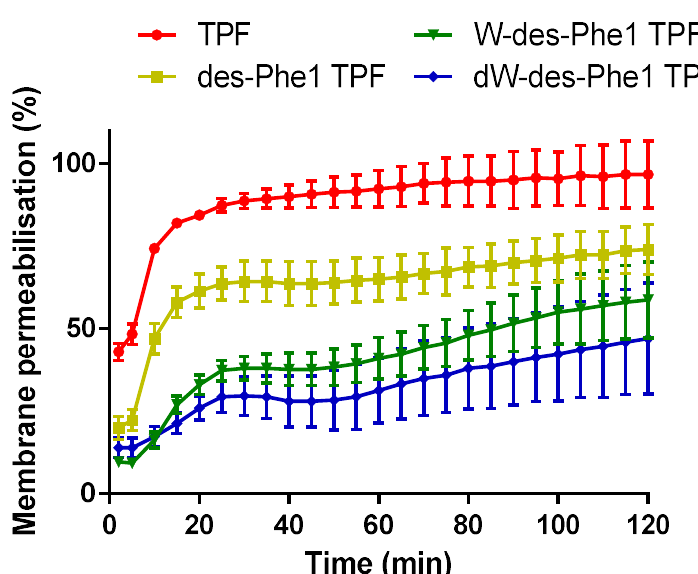
Figure 10. Membrane permeabilization effect of TPF and the analogs (10 μM) on Gram-positive bacteria S. aureus was indicated by the uptake of SYTOX Green dye over 120 min. The error bar represents SD of three replicates.